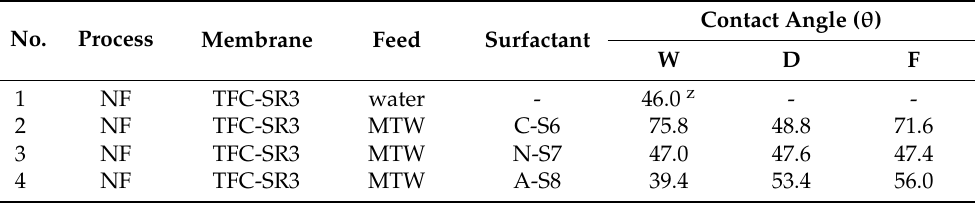
Table 3. Average values of the contact angle of the NF